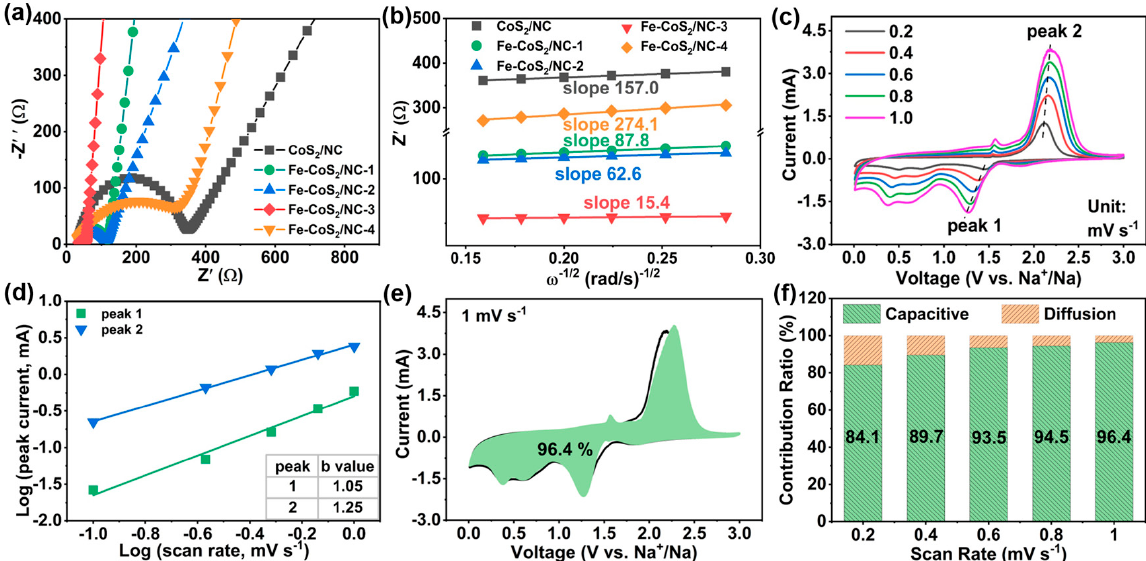
Figure 5. ( a ) Nyquist plots and ( b ) linear fi tt ing of Z ′ versus ω − 1/2 of the Fe-CoS 2 /NC-3, CoS 2 /NC, Fe- CoS 2 /NC-1, Fe-CoS 2 /NC-2, and Fe-CoS 2 /NC-4 electrodes, for these electrodes, ( c ) the CV curves at di ff erent scan rates, ( d ) linear relationship between log( i ) and log( v ) for selected peaks of CV curves, ( e ) the capacitive contribution at 1.0 mV s − 1 marked by the colored region, and ( f ) contribution ratio of the capacitive and di ff usion-controlled capacities at di ff erent scan rates for the Fe-CoS 2 /NC-3 elec- trode.